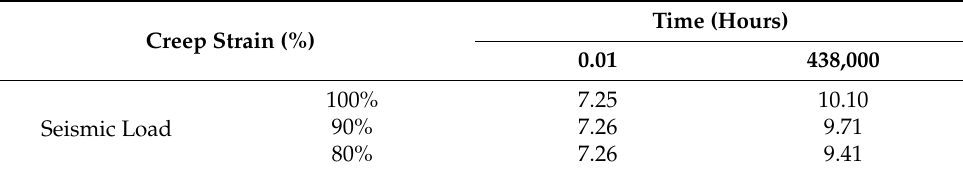
Table 12. Creep strain of LCP woven geotextile during creep test by 60% of UTS at initial and critical